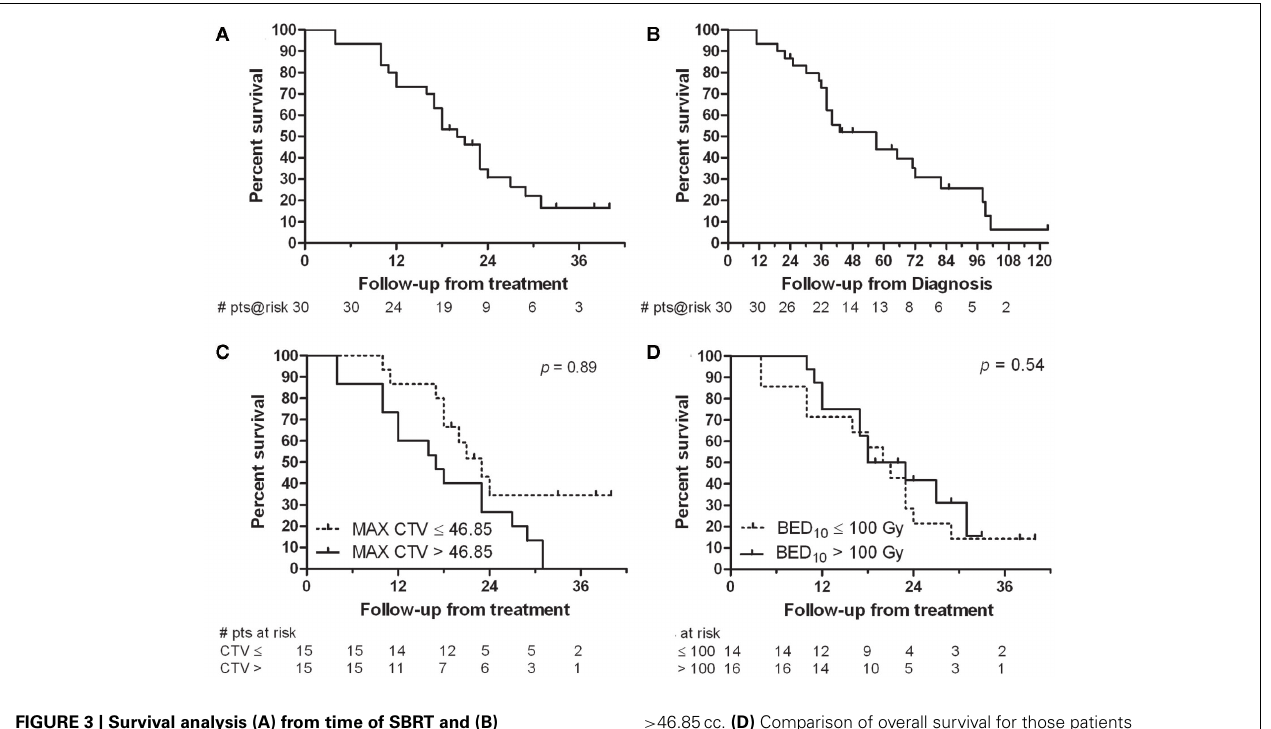
FIGURE 3 | Survival analysis (A) from time of SBRT and (B) from time of diagnosis. (C) Comparison of overall survival for patients with a largest CTV ≤ 46.85cc to those with a largest CTV